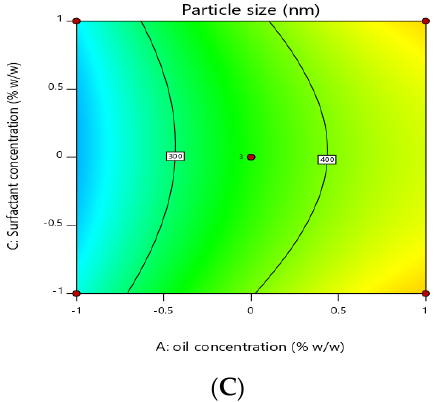
Figure 2. Contour plot showing the effect of independent factors X1 (oil concentration), X2 (stirring speed) and X3 (surfactants concentration) on responses Y1 and Y2. ( A ) effect of surfactant concen- tration and stirring speed on particle size ( B ) effect of stirring speed and oil concentration on particle size. ( C ) effect of surfactant concentration and oil concentration on particle size.